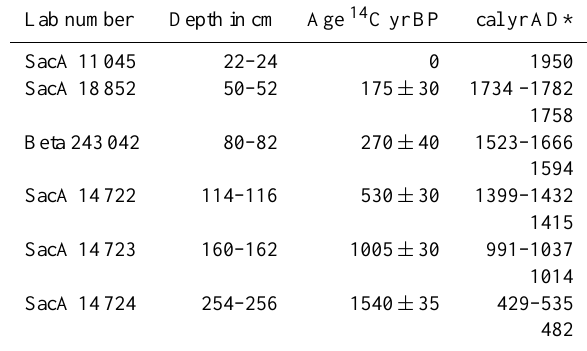
Table 1. Chronology of core PA 1-08. Radiocarbon ages were mea- sured on total organic matter. Calibrated ages were calculated from Calib 6.01 (Stuiver et al., 1998, 2011; J¨oris and Weninger, 1998). Lab number Depth in